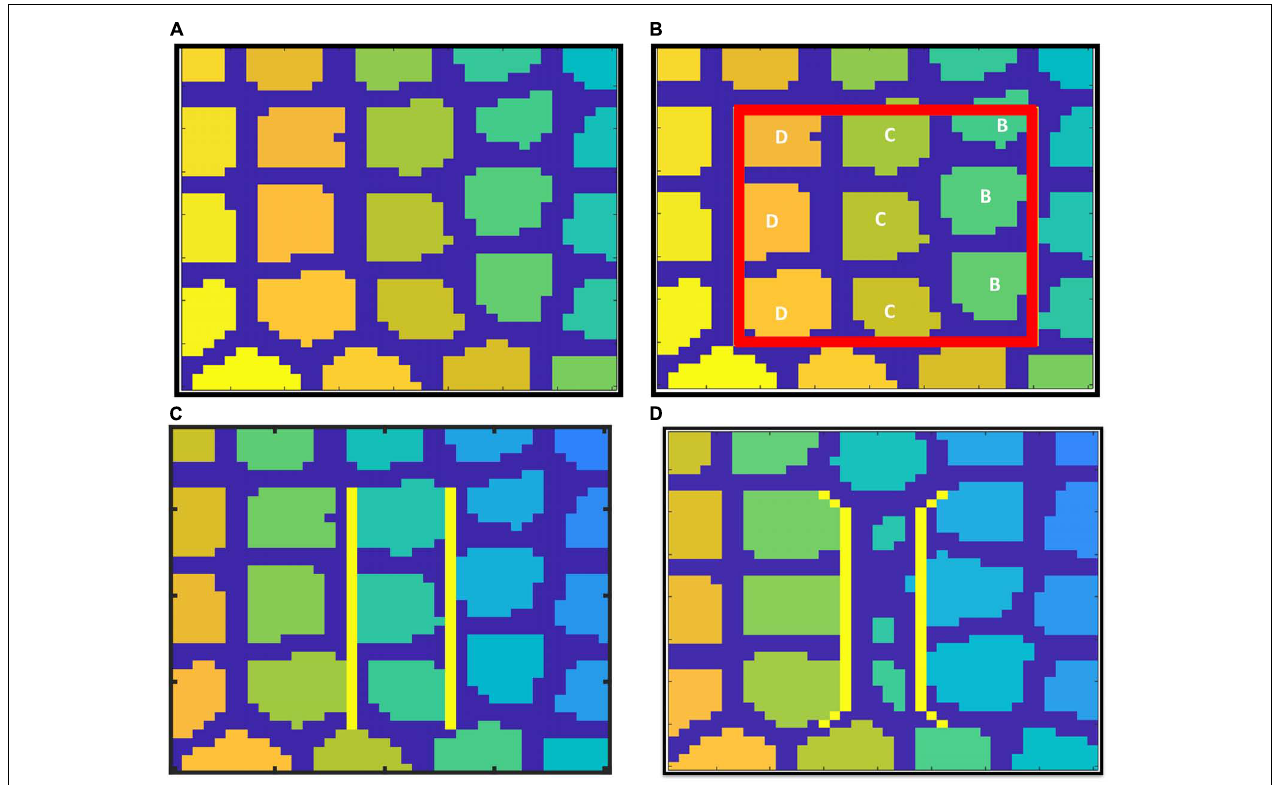
FIGURE 13 | SOM trained to represent whisker barrel cortex: (A) full whisker barrel cortex. (B) The 0.6 mm × 0.6 mm area corresponding to the cortical tissue considered for A-VAM, (C) boundary of C row barrels in control model, and (D) boundary of C row barrels in lesioned Model.